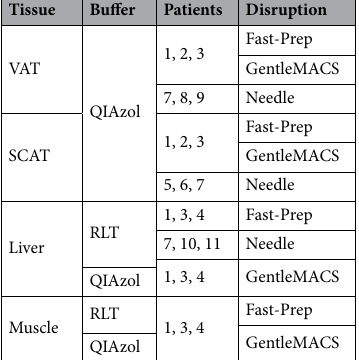
Table 2. Experimental protocols. Sample origin, homogenization buffers (RLT versus QIAzol) and methods (FastPrep for FastPrep Instrument, GentleMACS for GentleMACS Dissociator, Needle for syringe/needle) used were reported for each tissue